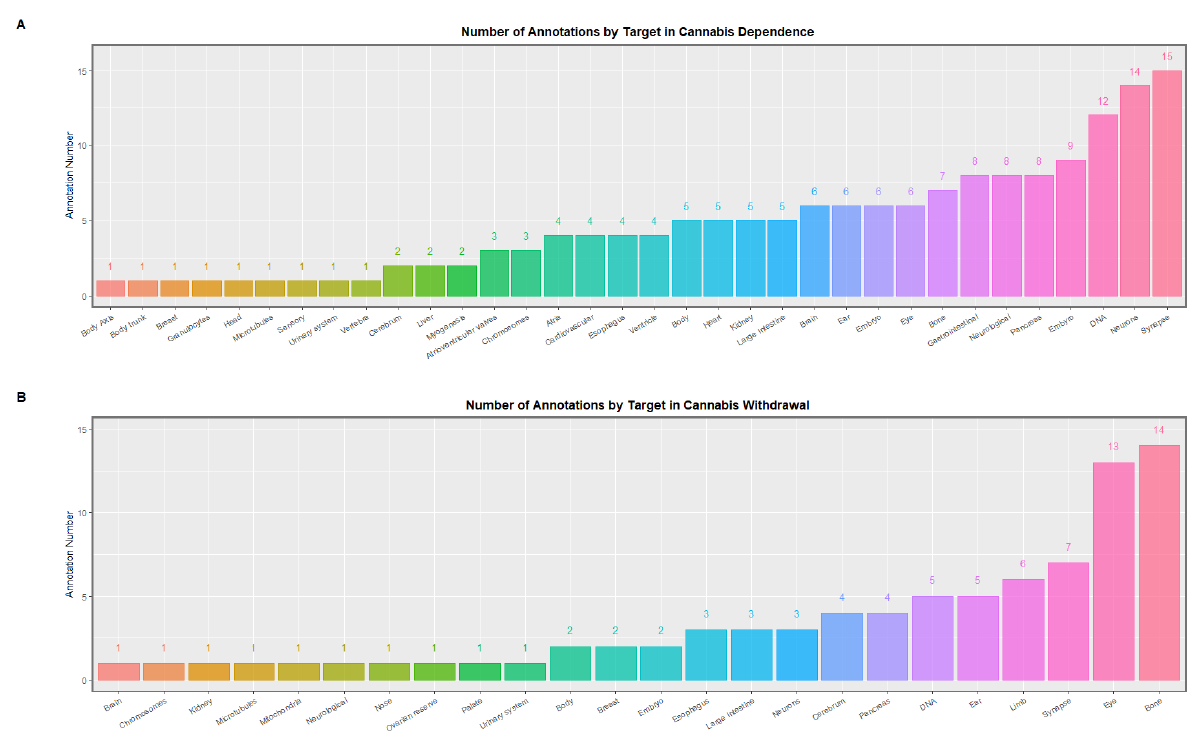
Figure 1. Number of epigenomic annotations in the Schrott database for target organs by dependency status in ( A ) cannabis dependence and ( B ) withdrawal.